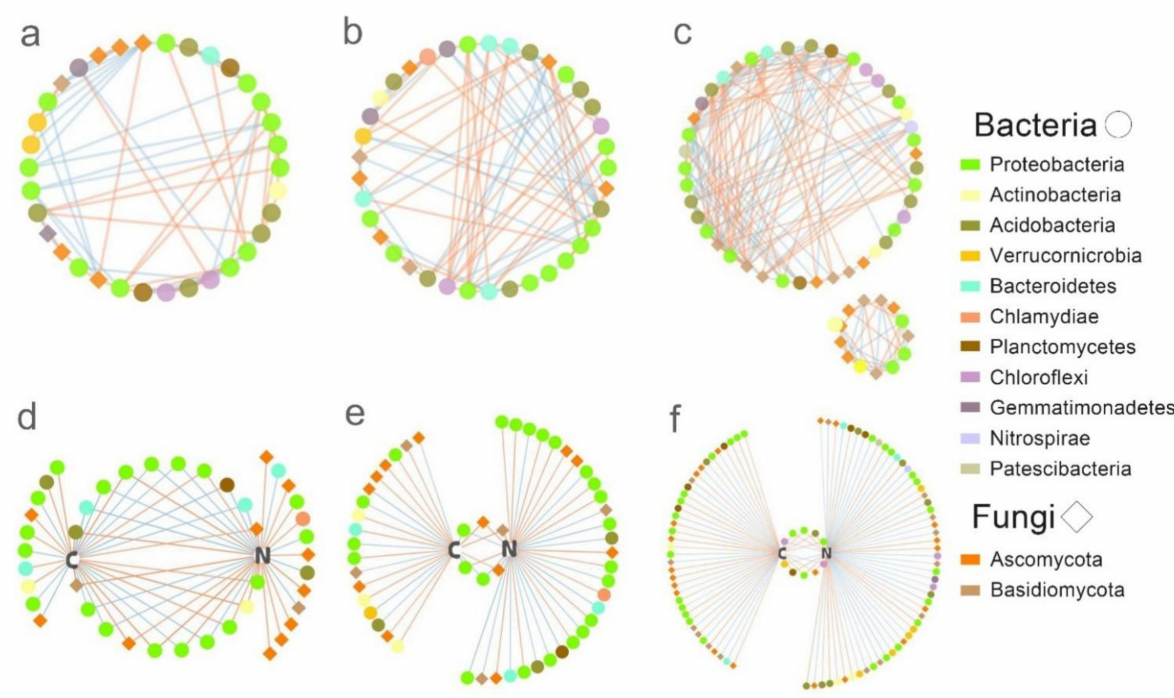
Figure 6. Co-occurring network of microorganism communities in Monoculture, PL, and PB based on correlation analysis. The connections stand for strong (Spearman’s p > 0.8 and p < − 0.8) and significant ( p < 0.001) correlations. ( a ), P-L-B; ( b ), P-L-PL; ( c ), P-B-PB. The connections stand for strong (Spearman’s p > 0.6 and p < − 0.6) and significant ( p < 0.05) correlations in co-occurring networks of soil carbon and nitrogen content. ( d ), P-L-B; ( e ), P-L-PL; ( f ), P-B-PB. Edges colored by positive (orange) and negative (blue)